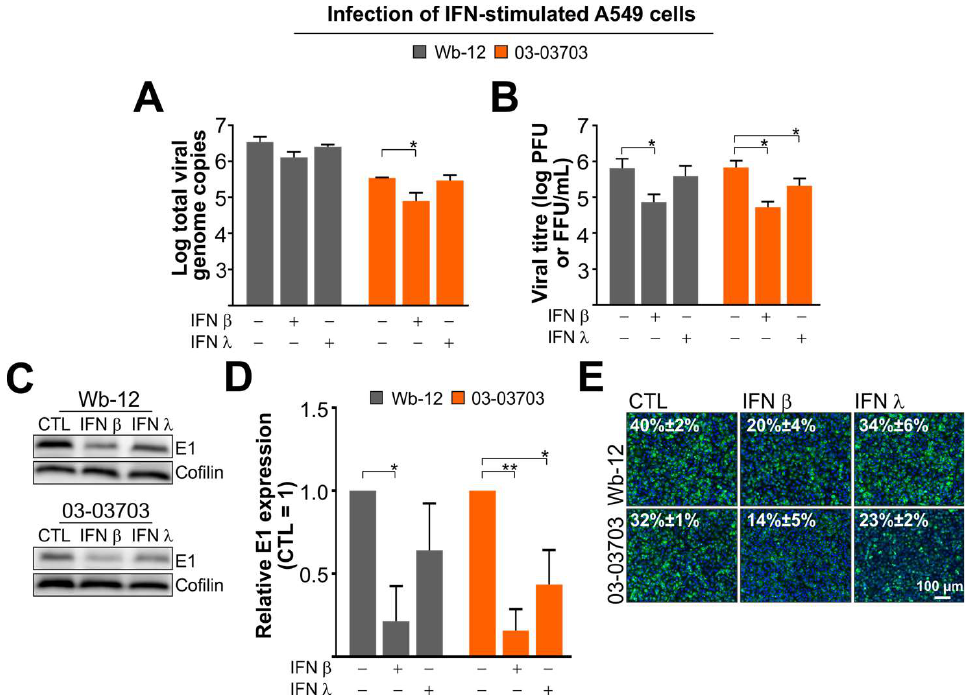
Figure 5. Stimulation of A549 cells with exogenous type I (IFN β) and III (IFN λ) IFNs affected RV infection. A549 cells were stimulated with IFN β or IFN λ (λ1, 2 and 3) for 72 h. Infection was compared to the untreated control (CTL) through assessment of ( A ) viral genome copies by TaqMan- based reverse transcription PCR and ( B ) titre determination by plaque and focus forming assay for samples collected at 1 dpi; ( C ) At 1 dpi E1 expression level in the absence or presence of exogenous IFN was determined with anti-E1 antibodies by Western blot analysis; ( D ) For assessment of relative E1 band intensities LI-COR image software was used. Indicated data is given as mean ±SE derived from three independent Western blot runs after normalization to cofilin; ( E ) Immunofluorescence analysis was performed at 1 dpi with anti-E1 antibodies (shown in green). Nuclei were stained with the DNA counterstain Hoechst bisbenzimide (shown in blue). Values in immunofluorescence images depict the mean percentage of RV-infected cells as determined by counting of the number of E1- positive cells in two random fields for two independent samples; ( C , E ) The images shown are representative for three independent experiments. *, p < 0.05; **, p < 0.01. 3.6. An Equal Infection Rate of RV Strains on M1- and M2-Mφ Occurred in Association with a Strong Type I and III IFN Response RV infection of M1- and M2-Mφ as human primary cells was carried out to determine if the IFN induction phenotype and sensitivity of A549 cells was also found in immune cells. We chose these cells as they are a promising cell type for analysis of RV infection, since granuloma M2-Mφ and alveolar Mφ in tissue samples of fatal CRS cases supported persistent RV infection [20,32]. Due to their central immunological functions they could play an important role in RV pathogenicity [33]. Furthermore, their high turn-over rate of glutamine could support replication of RV strains [10]. Mφ differentiated from monocytes derived from three different donors were infected with RV strains Wb-12 and 03-03703. In contrast to the lower infection rate of 03-03703 strain on Vero cells [10], the number of E1-positive cells during infection of M1- and M2-Mφ was comparable between the two strains at 1 dpi. Interestingly, at 3 dpi they were even significantly higher for 03-03703 as compared to Wb-12-infected M2-Mφ (Figure 6A). This was also reflected in viral titre, which was comparable at 1 dpi but at 3 dpi on M2-Mφ titre of 03-03703 was significantly higher compared to Wb-12 strain (Figure 6B). Furthermore, it is important to note, that the course of infection of both strains was comparable between the two Mφ types (Figure 6A,B). Supernatants collected at 1 and 3 dpi were subjected to analysis of IFN concentration by the LEGENDplex IFN panel. The IFN type and concentration was comparable between M1- and M2-Mφ (Figure 6C). On both Mφ types differences were noted at 1 dpi between the two RV strains in the overall concentration of IFNs. The IFN